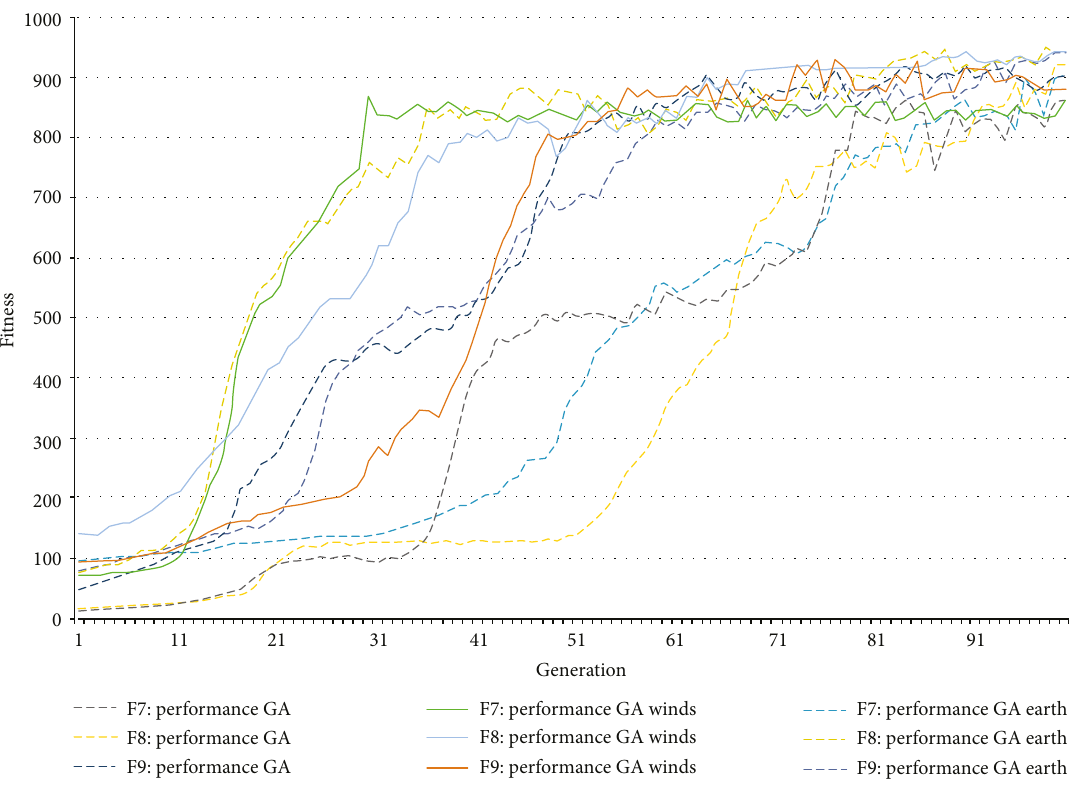
Figure 5: Evolution of the results in each generation with test functions F7, F8, and F9 using GA, GAP winds, and GAP earthquake.